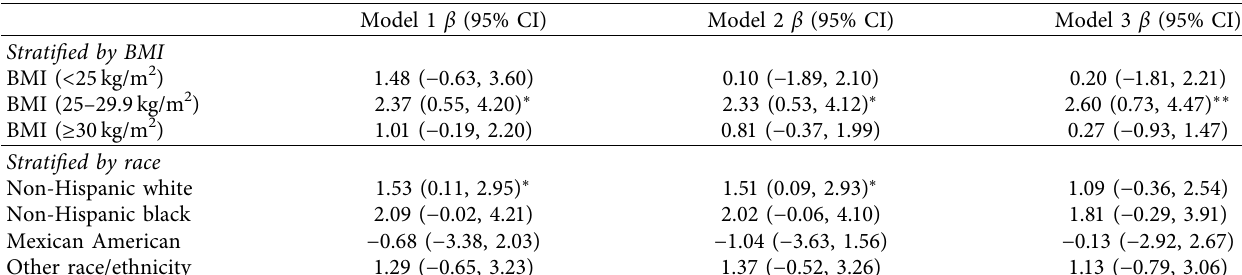
Table 3: Association between serum total testosterone levels (ng/dL) and lumbar bone mineral density (mg/cm 2 ), stratified by body mass index (BMI) and